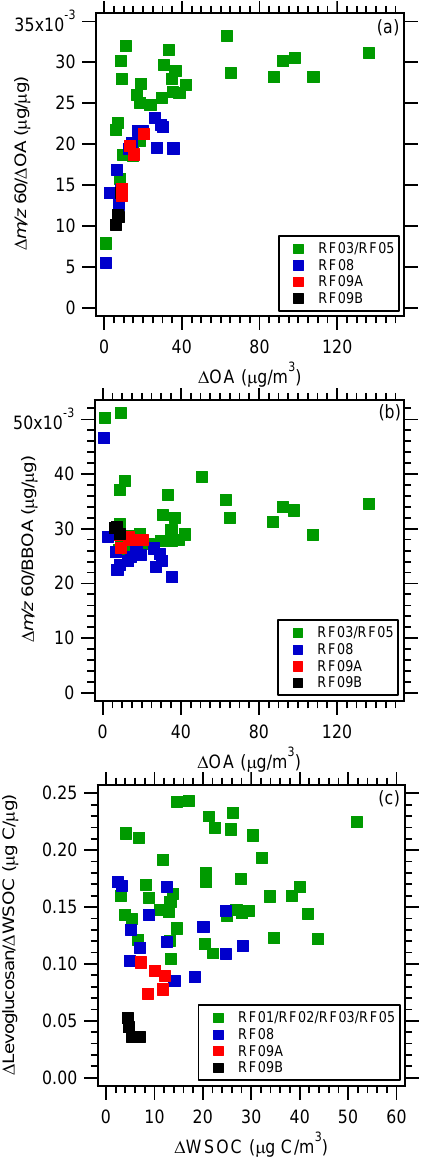
Figure 8. (a) 1m/z 60 /1 OA ratio as a function of 1 OA, (b) 1m/z 60 / BBOA ratio as a function of 1 OA, and (c) 1 levoglucosan /1 WSOC ratio on a carbon mass basis as a function of 1 WSOC for all flights with the data segregated by fire location.